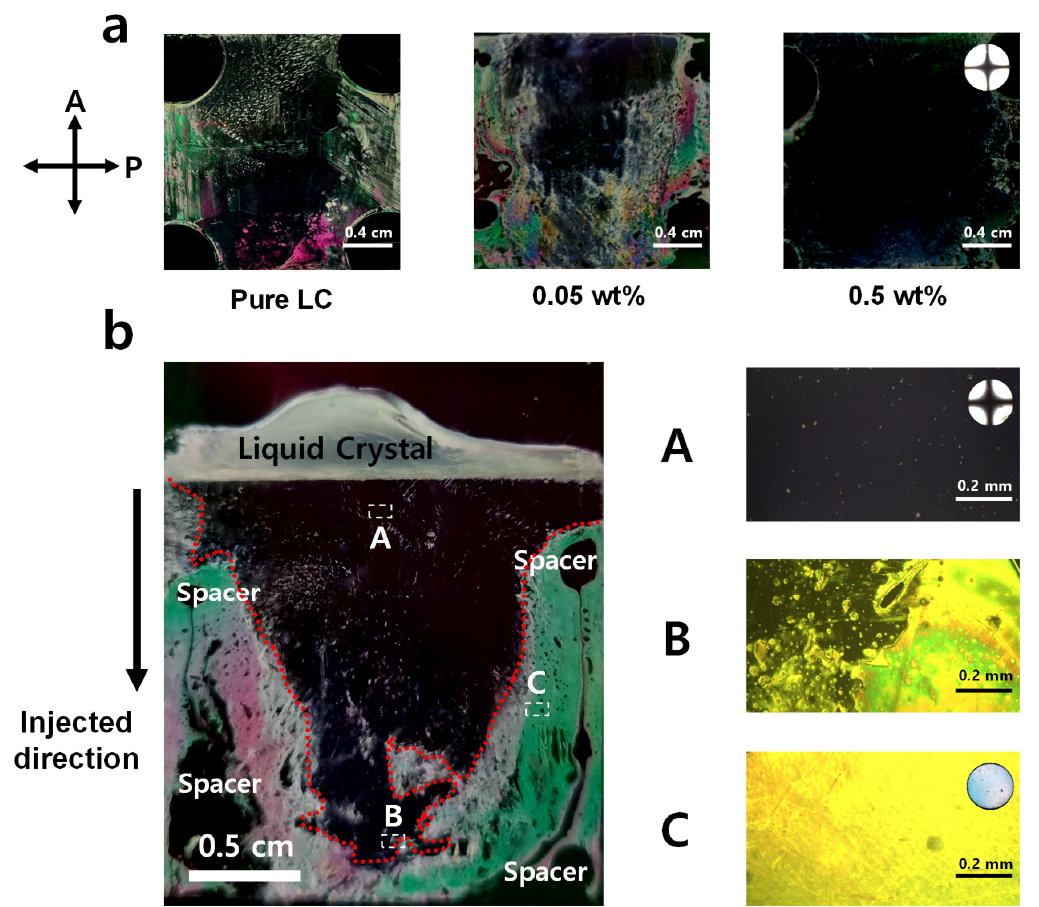
Figure 2. Image of region near LC injection with the test cell between the two cross-polarized polarizer films; ( a ) injected pure LCs, insufficient [HTAB] for homeotropic alignment, and LCs mixture with sufficient [HTAB] to induce fully-vertical alignment at the cell gap = 20 µm. LC mixtures with insufficient [HTAB] develop nonuniform LC orientation; ( b ) nonuniform LC cell with an insufficient [HTAB]. ( A ) polarized optical microscopy images of vertically well-aligned part near the LC injection point, ( B ) division area, and ( C ) imperfectly-aligned part far from the LC injection point.